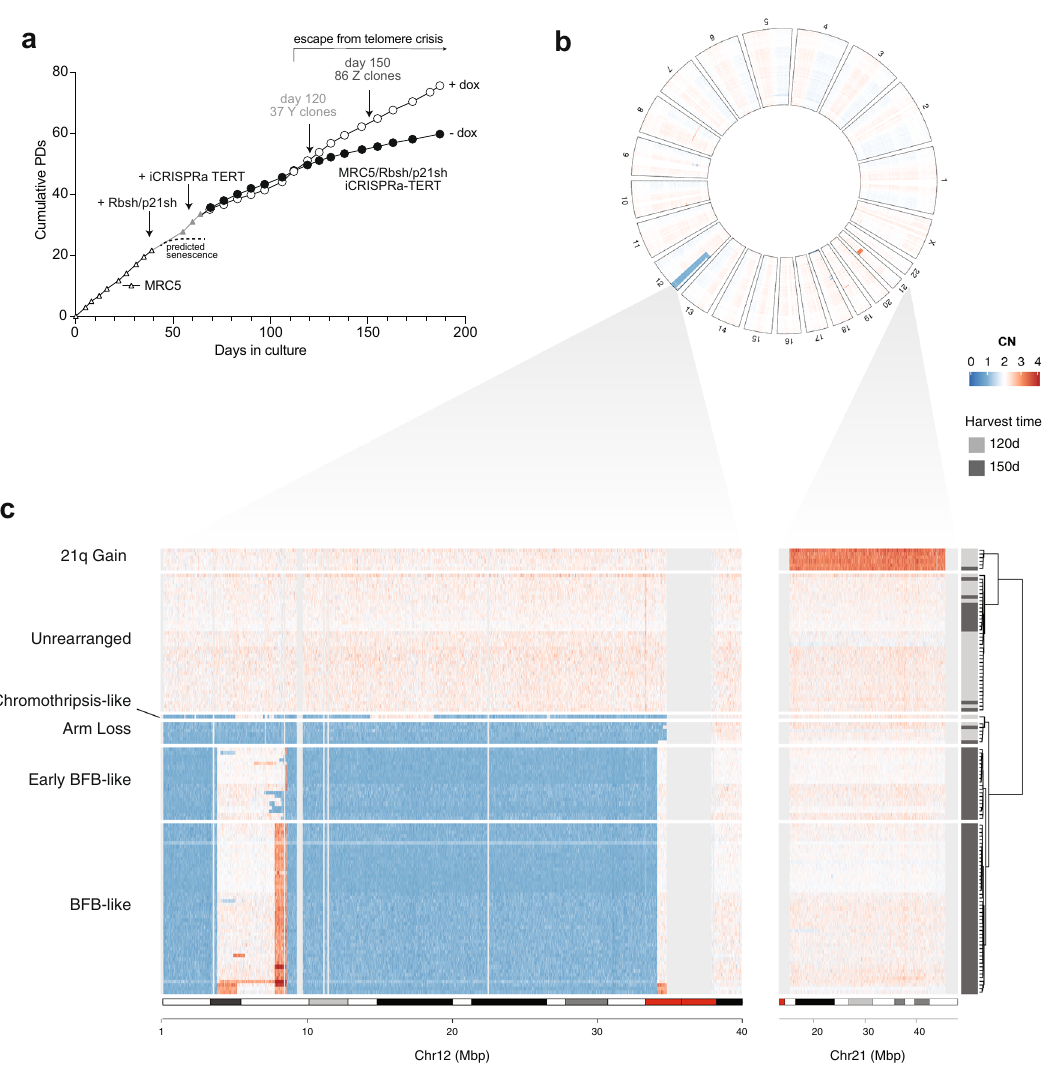
Fig. 4 Genomic screening of post-crisis clones. a Growth curve of MRC5/Rbsh/p21sh/iCRISPRa-TERT cells with and without doxycycline, indicating the time points at which single-cell clones were derived (day 120 and day 150). b Circular heatmap showing genome-wide binned purity- and ploidy- transformed read depth (in units of CN across 118 low-pass WGS-pro fi led clones. Heatmap rows correspond to concentric rings in the heatmap. Clones are clustered with respect to genome-wide copy number pro fi le similarity (see “ Methods ” ). c Zoomed-in portion of chromosomes 12 and 21 that underwent copy number alterations in a majority of the clones, clustered based on their coverage across these regions. Clusters are named with respect to their consensus copy number pattern, and on the basis of high-depth WGS analyses presented in Fig. 5. Chromosome 21 gain n = 6 clones; unrearranged n = 38; chromothripsis-like n = 1; arm loss n = 6; early BFB-like n = 20; BFB-like n = 47.